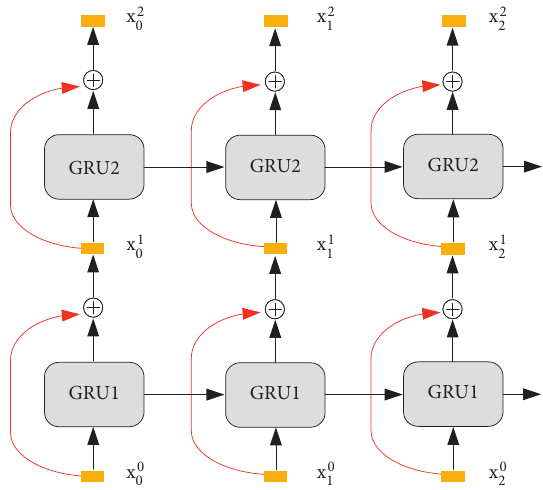
Figure 4: Structures of stacked GRU with residual connections.